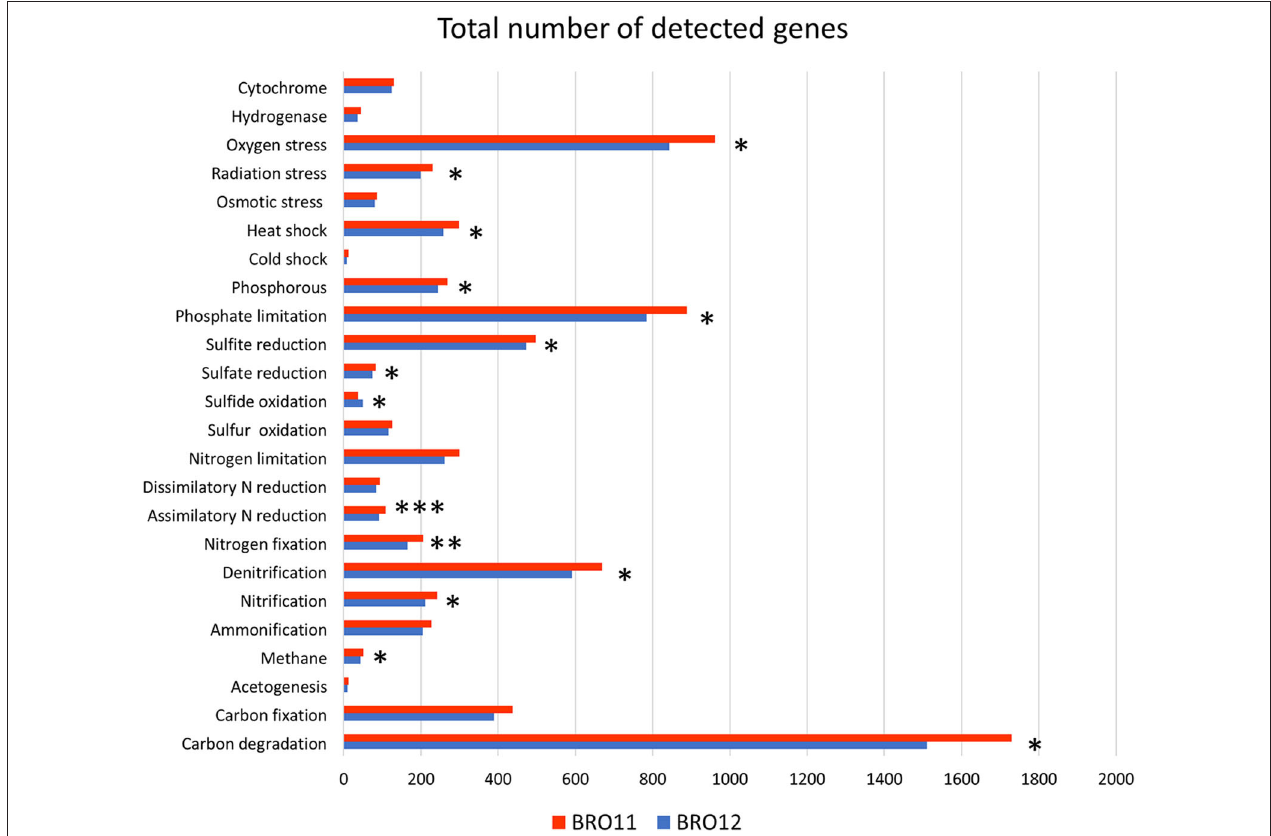
FIGURE 4 | Results of metagenomic analysis of soils BRO11 and BRO12 by means of Geochip 3.0. The total number of the detected functional genes is reported for each gene category. Asterisks indicate significant differences of the variable means between BRO11 and BRO12 genes (* p < 0.05; ** p < 0.01; and *** p < 0.001).